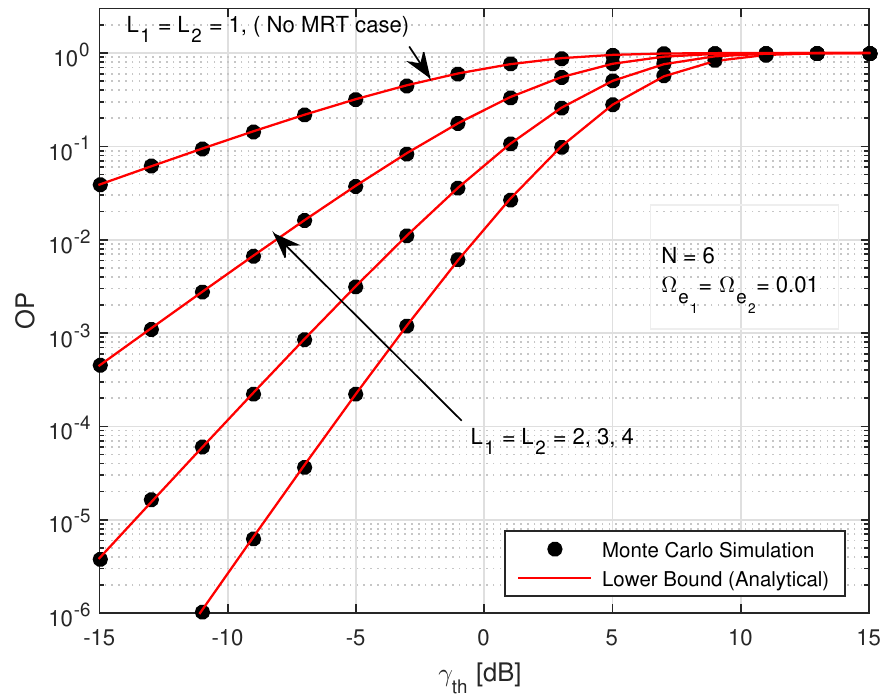
Figure 10. System outage probability vs SINR threshold for different number of antennas, P I = 10 dB = Ω e = and Ω e 2 1